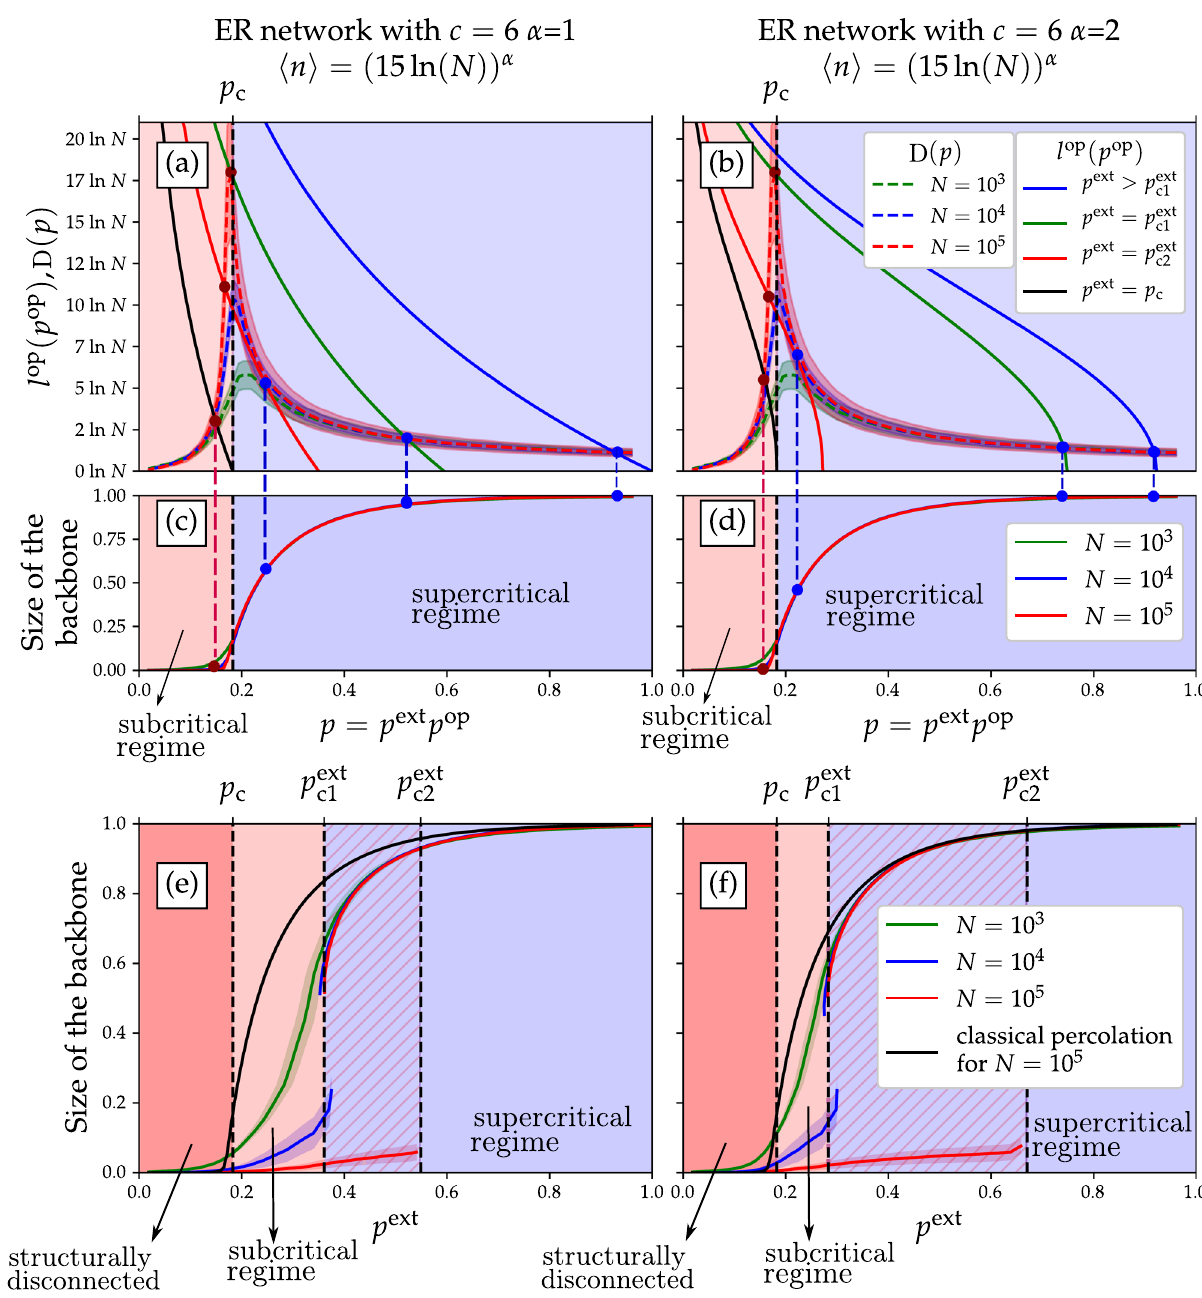
Fig. 3 Robustness of a quantum Erd ő s-Rényi network. Exploration of bond percolation on a quantum Erd ő s-Rényi network (ER) with average degree c = 6 where the number of entangled pairs in each link follows an exponential distribution with mean number 〈 n 〉 . We plot the operational distance l op and the network diameter d versus the probability that links are both operational and not removed p = p op p ext , for h n i ¼ 15ln N ð Þ α with α = 1 in a and h n i ¼ 15ln N ð Þ α with α = 2 in b , respectively. The large colored dots indicate their intersection. Here the operational distance l op and network diameter d are scaled by ln N for ease of comparison. Labelled are the curves l op ( p op ) for p ext ¼ p ext ( p ext ) which correspond to the smallest (largest) value of p indicating a c1 c2 stable l op ( p op ) = D ( p op p ext ) solution in the subcritical regime. Further the classical percolation critical probability p c gives the point where the networks breaks completely apart to become structurally disconnected meaning there is no giant set of nodes that can connect to each other with any fi delity. We generated one Erd ő s-Rényi network for each value of N , then d op ( p ) was determined by removing each link of the network with probability 1 − p . d op ( p ) was computed based on 100 runs for each value of p . The intersection between the two nodes at p 0 , is marked by blue dots for solutions in the supercritcal regime, and red dots for solutions in the subcritical regime. Next the size of the backbone (number of nodes in the backbone) is plotted as a function of in b for α = 1. intersection point found in a, b ) there is a corresponding size in c, d . Finally the size of the backbone is plotted as a function of the probability that links are not removed p ext in e, f for α = 1, 2. The functionally connected regime is represented as the blue region while the functionally subcritical regime is shown as the light red region. The blue/red stripped area represents the region where both the functionally connected and subcritical regimes are stable. The dark red region on the other hand represents the structurally disconnected regime for a network of size N = 10 5 . Shaded region around each curve represents the standard deviation of the